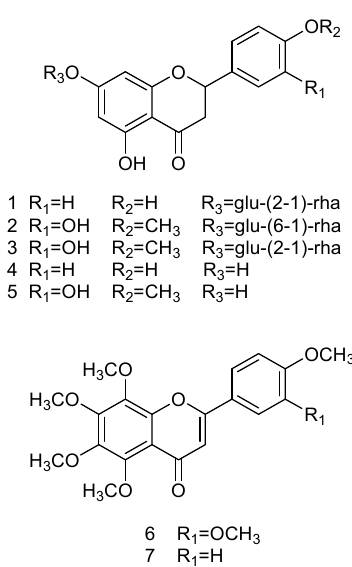
Figure 1. Structures of the compounds identified from the ethyl acetate extract of C . aurantium dried immature fruits: naringin ( 1 ); hesperidin ( 2 ); neohesperidin ( 3 ); naringenin ( 4 ); hesperetin ( 5 ); nobiletin ( 6 ); and tangeretin ( 7 ).